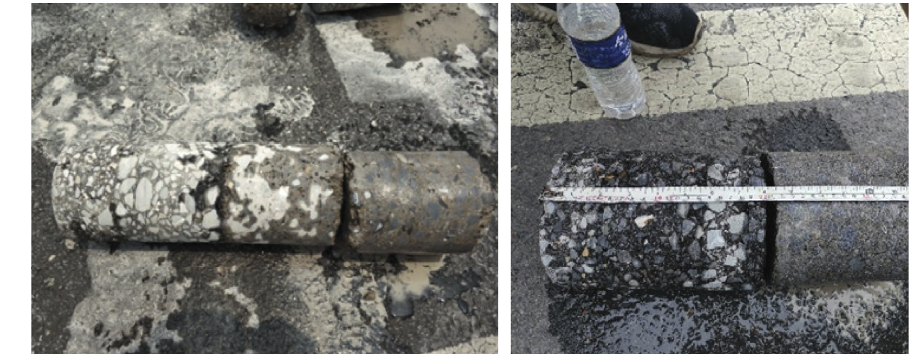
Figure 7: On-site sampling of asphalt pavement.